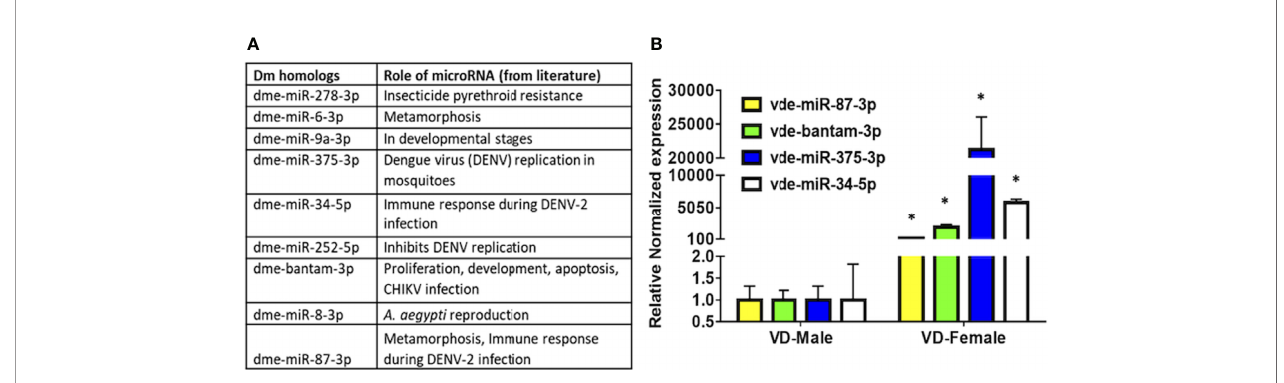
FIGURE 4 | (A) MicroRNA candidates predicted in this study, conserved in other arthropods, and validated in the available literature play signi fi cant roles in replication, harboring, and inhibition of viral pathogens. (B) qRT-PCR expression of potential microRNAs found in the present study in DWV-B-infected male and female Varroa mites. Succinate dehydrogenase ( SDHA ) was used as the housekeeping gene for normalization. Expression of these microRNAs is comparatively higher in female than male Varroa . Statistical signi fi cance for qRT-PCR-based differential expression was determined using the two-tailed Student ’ s t -test, where * denotes p < 0.05.